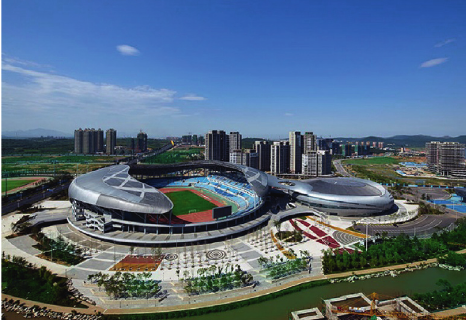
Figure 4: Huludao sports centre.